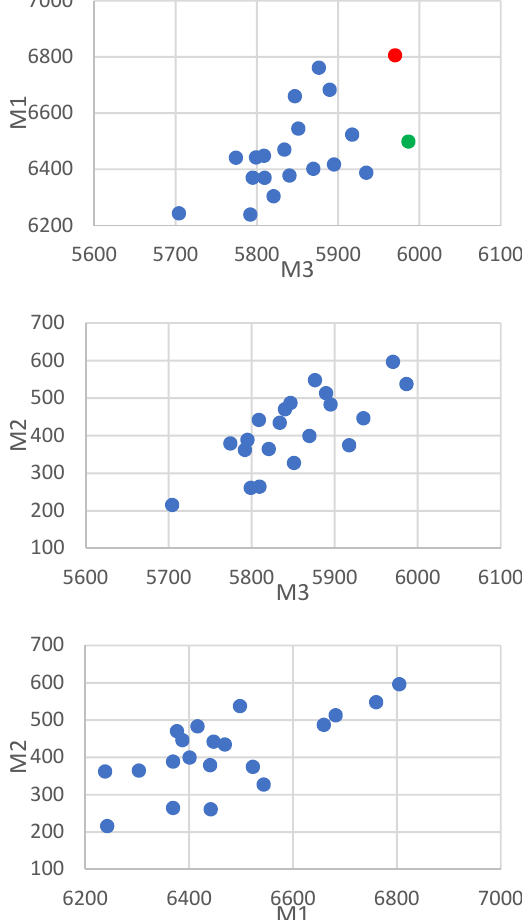
Figure 3. Pairwise comparison of performance of each of 20 alternatives on regret metrics. Each point is one alternative.